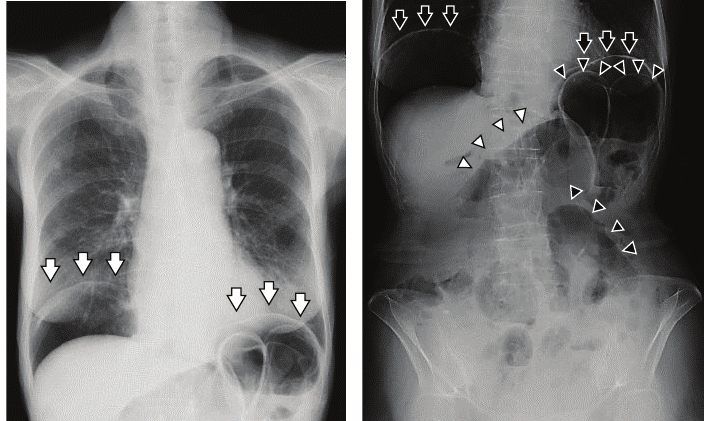
Figure 1: A chest radiograph demonstrating pneumoperitoneum in the subdiaphragmatic regions bilaterally (arrows). A plain abdominal radiograph showing several dilated loops of small intestine